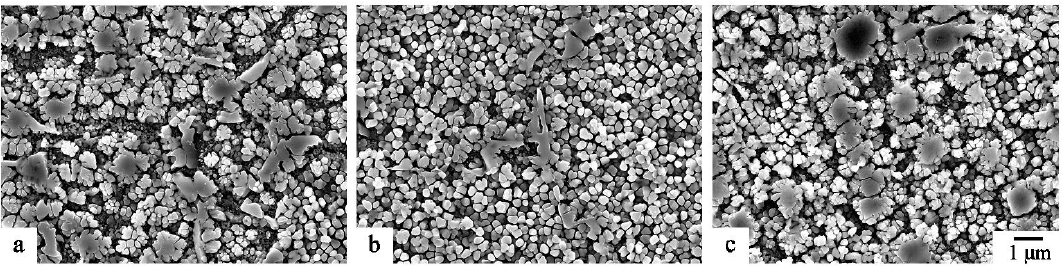
Figure 3. Microstructures of the D2 ( a ), D4 ( b ), and D6 ( c ) alloys after aging at 1123 K for 8 h.